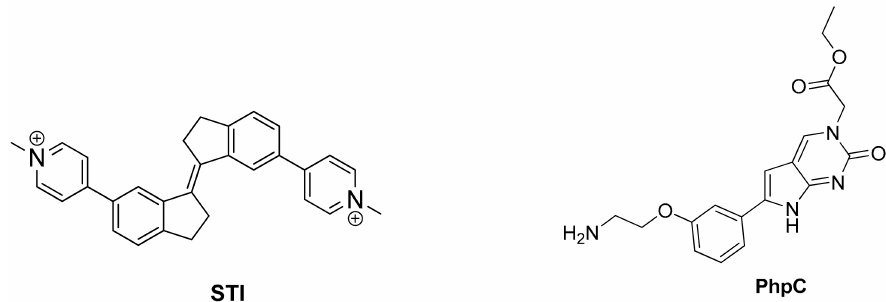
Figure 20. Structures of G4 ligands with capacity to disrupt the quadruplex